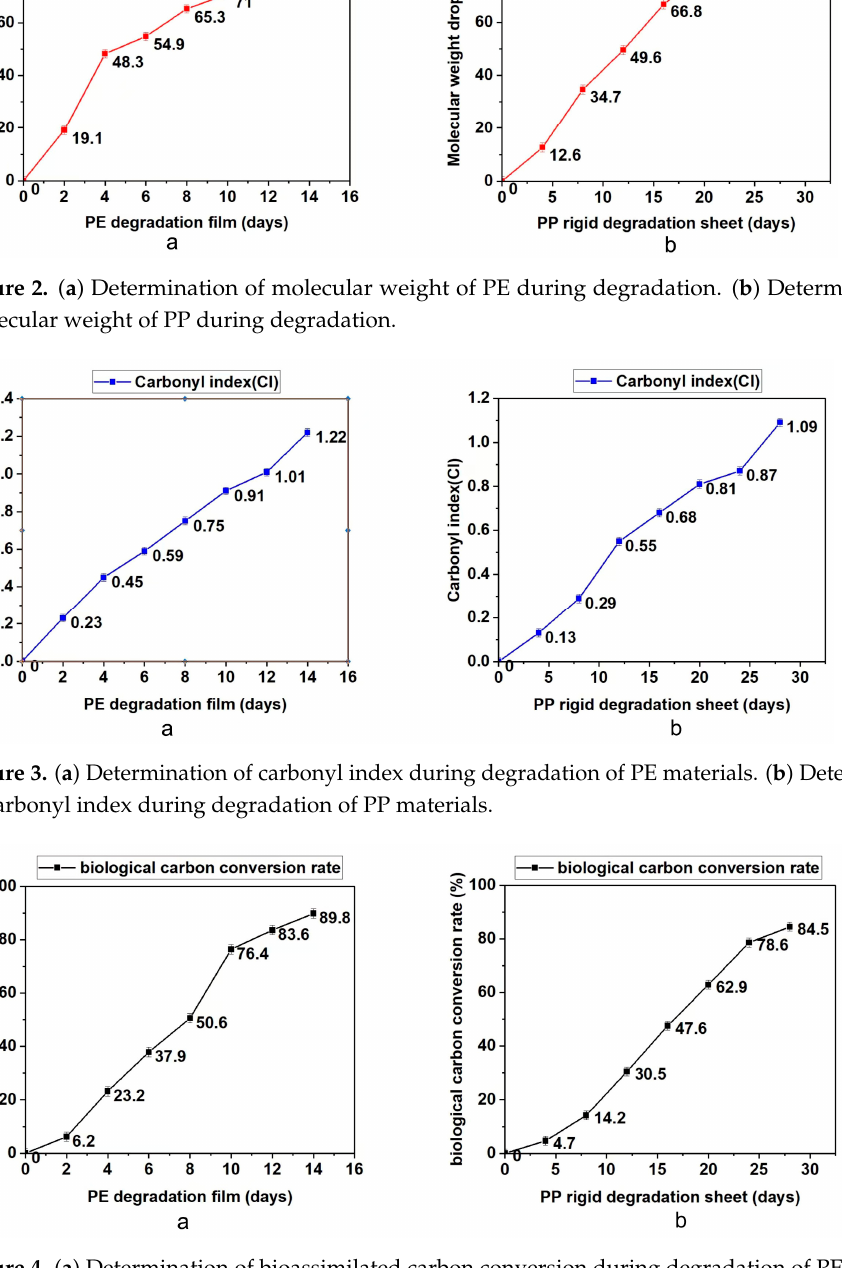
Figure 4. ( a ) Determination of bioassimilated carbon conversion during degradation of PE materials. ( b ) Determination of bioassimilated carbon conversion during degradation of PP